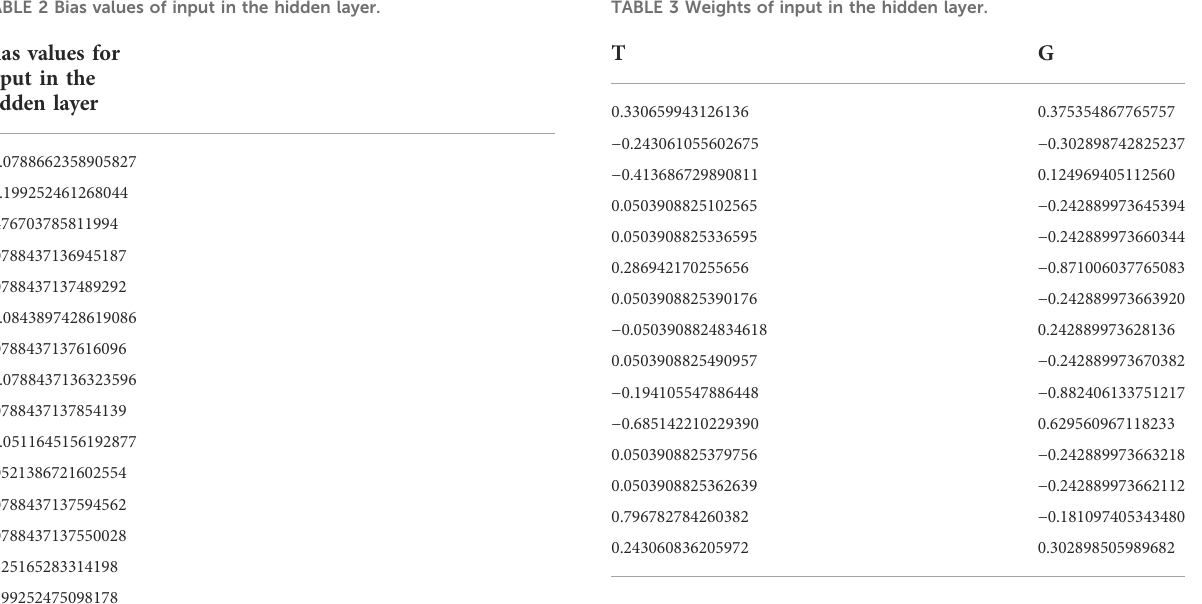
TABLE 3 Weights of input in the hidden